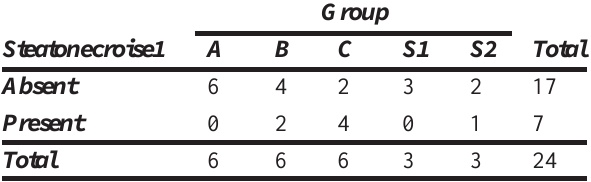
TABLE 2 - Interstitial infiltrate in each group Group FIGURE 6 - Interlobular septum size in each group, showing cellular edema. The size of interlobular septum rose progressively